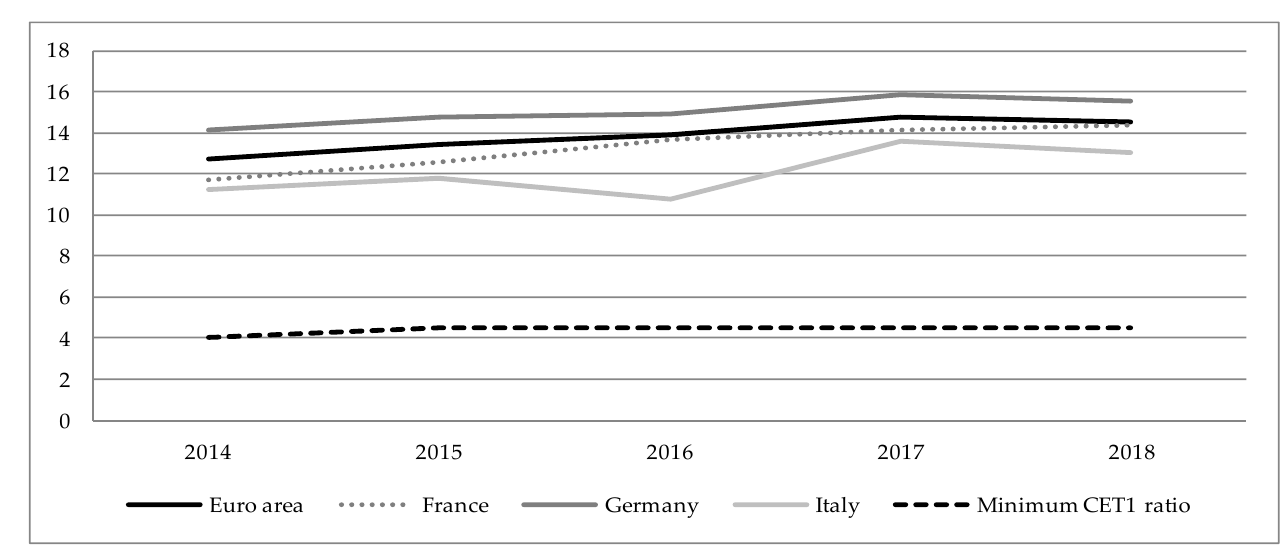
Figure 3. Common Equity Tier 1 in the analyzed countries on the background of the euro area in the years of 2014–2018—in percent (source: own work based on the ECB data).